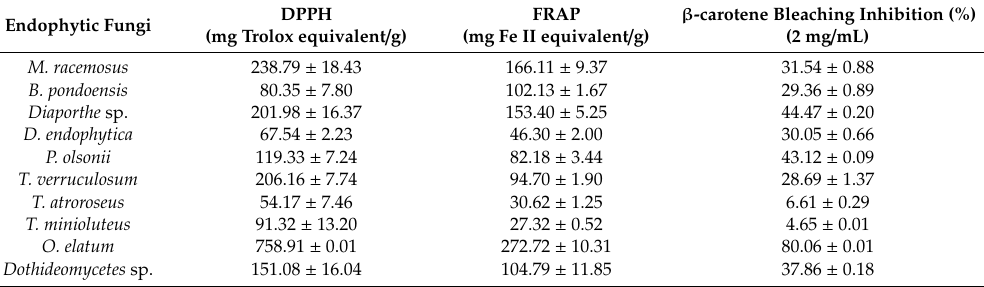
Table 4. Antioxidant properties of the extracts of the endophytic fungi from S. terebinthifolius . Endophytic Fungi